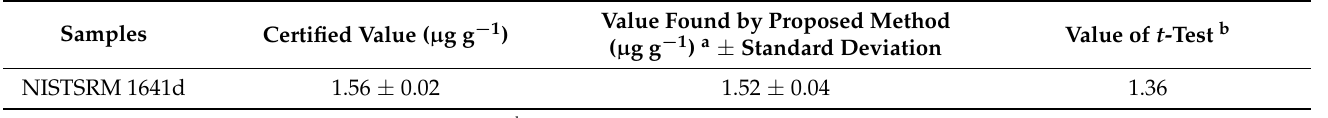
Table 3. Analytical method validation of the proposed methodology.